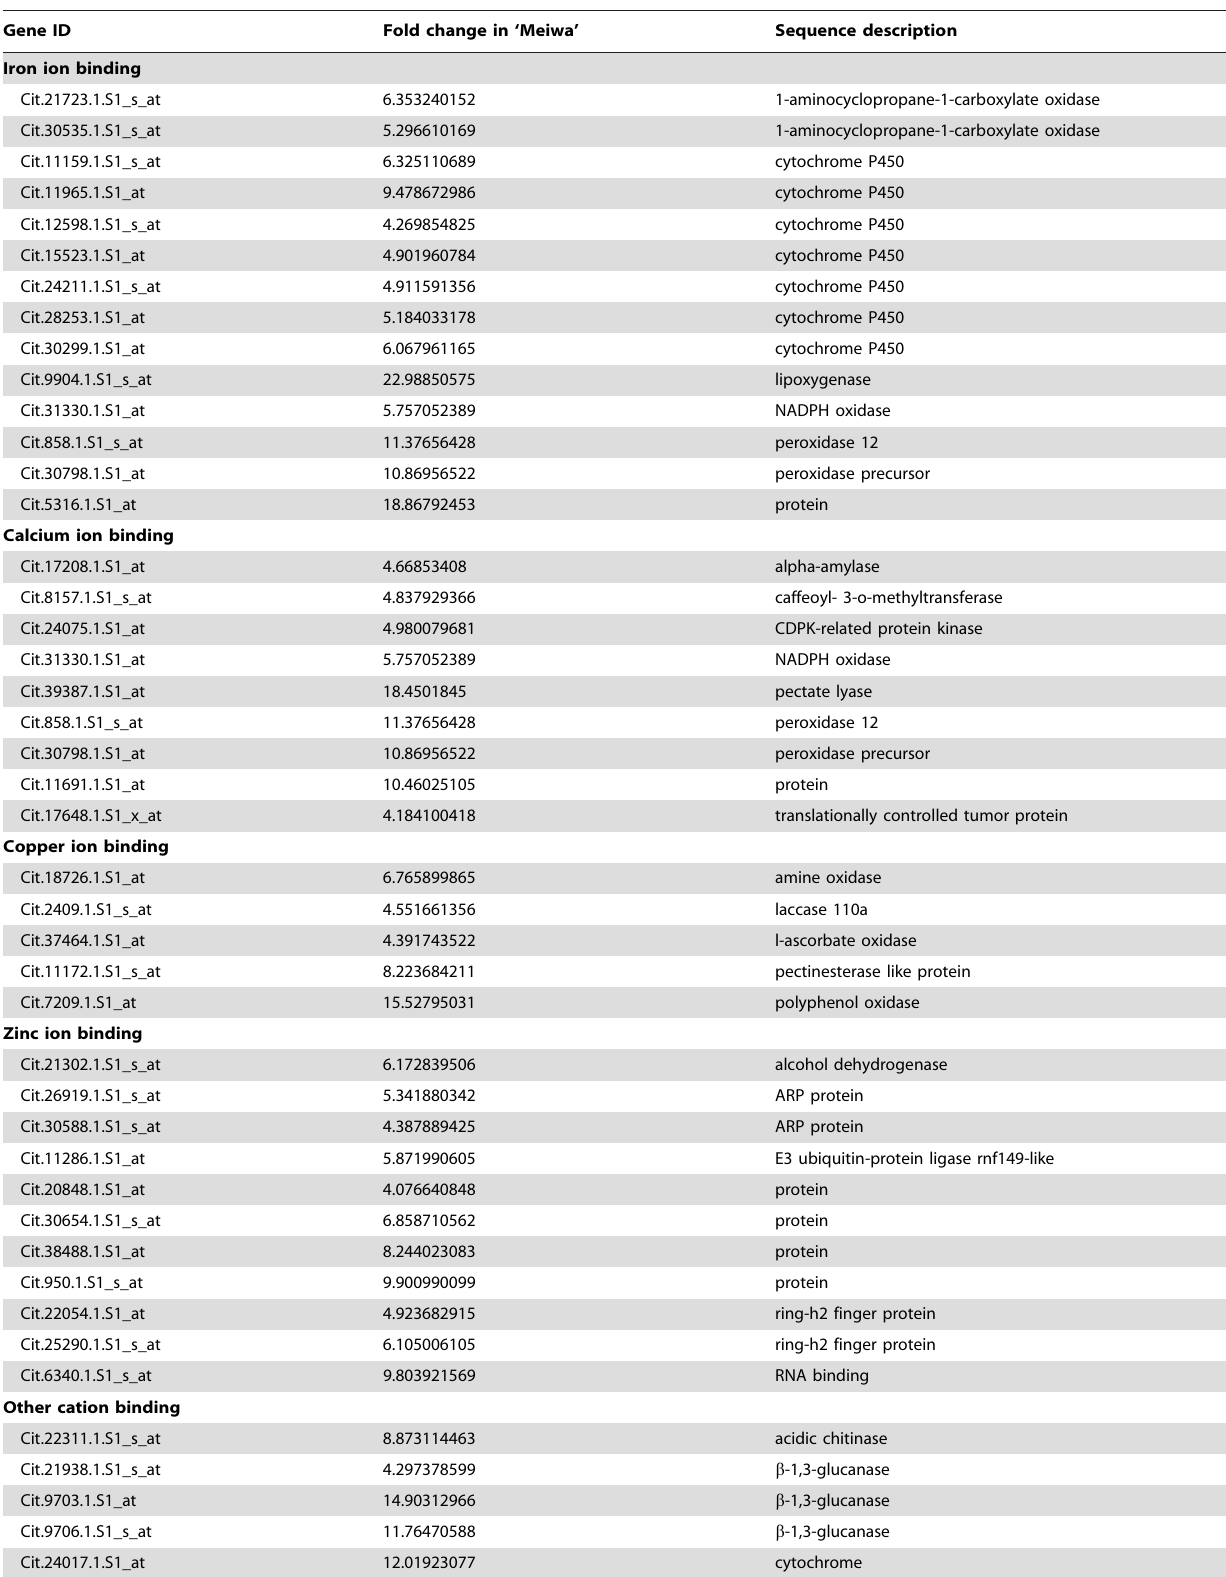
Table 6. Significantly enriched cation binding related genes in ‘Meiwa’ specifically regulated gene cluster.